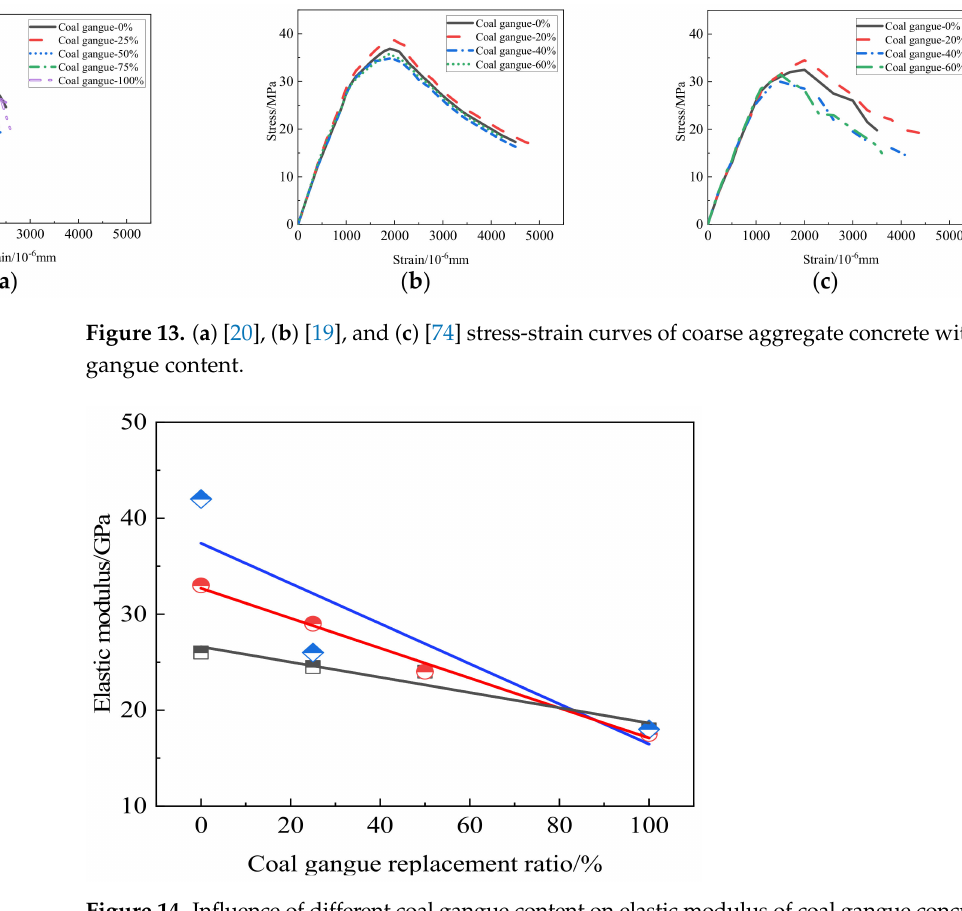
Figure 14. Influence of different coal gangue content on elastic modulus of coal gangue concrete